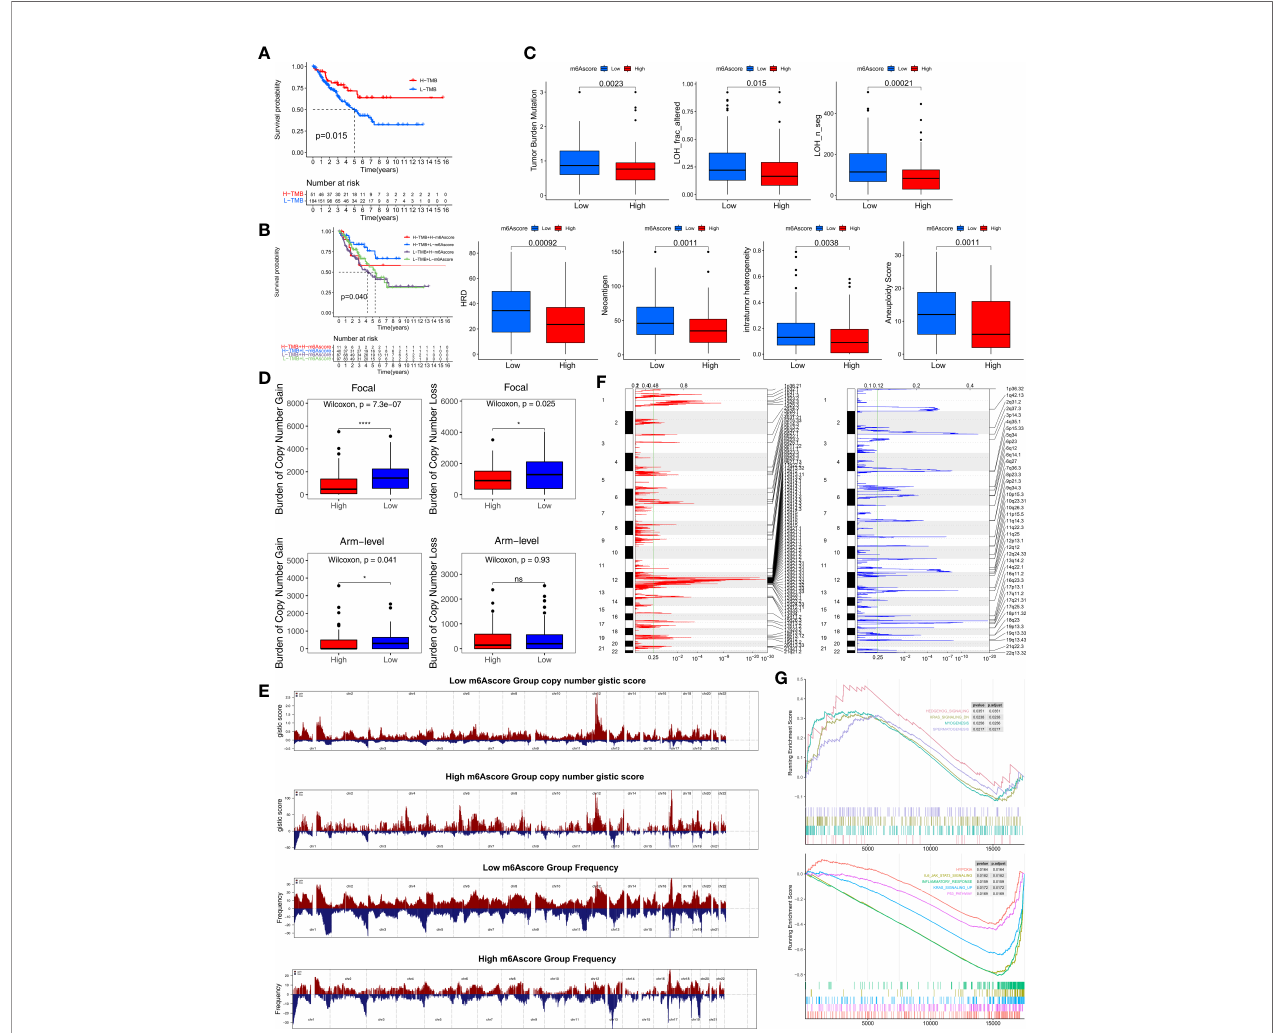
FIGURE 5 | Multiomics analysis of the role of m6Ascore. (A) Kaplan-Meier curves depicting survival analyses for low (184 cases) and high (51 cases) TMB patient groups in the TCGA-SARC cohort using Log-rank test. (B) Kaplan-Meier curves depicting survival analyses for subgroup patients strati fi ed by both m6Ascore and TMB levels using Log-rank test. (C) Differences in the m6Ascore between TMB, neoantigen burden, DNA damage including homologous recombination de fi ciency (HRD), loss of heterozygosity (LOH; number of segments with LOH events, and fraction of bases with LOH events), intratumor heterogeneity (ITH), and aneuploidy score in the TCGA-SARC cohort. The upper and lower ends of the boxes represented an interquartile range of values. The lines in the boxes represented the median value, and the dots showed outliers. (D) Distribution of and focal and broad (arm-level) copy number alterations in the low or high m6Ascore groups. The statistical signi fi cance of pairwise comparisons is annotated with symbols in which ns and * represent not signi fi cant (P > 0.05) and P ≤ 0.05, respectively. (E) Copy number pro fi les for the low or high m6Ascore groups, with gains in red and losses in blue. Gene segments are placed according to their location on chromosomes, ranging from chromosome 1 to chromosome 22. (F) Detailed cytoband with focal ampli fi cation (left) and focal deletion (right) in the low-m6Ascore group generated with GISTIC_2.0 software. The q value of each locus is plotted horizontally. (G) GSEA plots showing the activated and suppressed gene sets between the high and low m6Ascore groups. Each run was performed with 1,000 permutations. ns, no signi fi